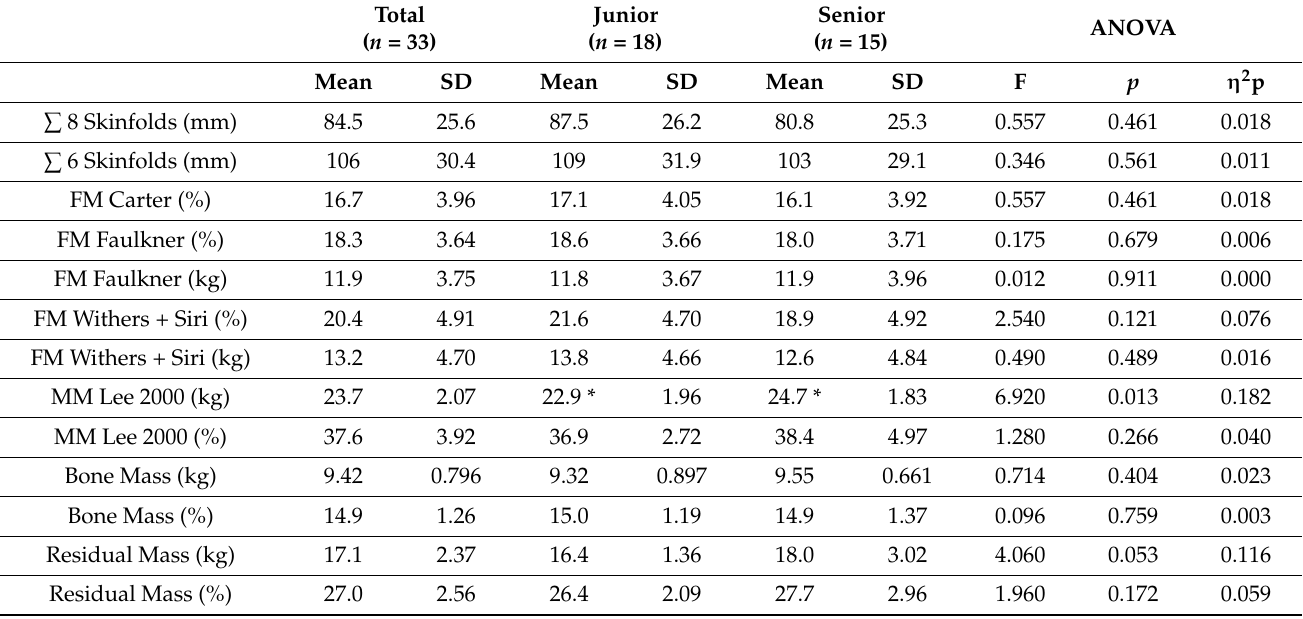
Table 4. Skinfolds and body composition by age